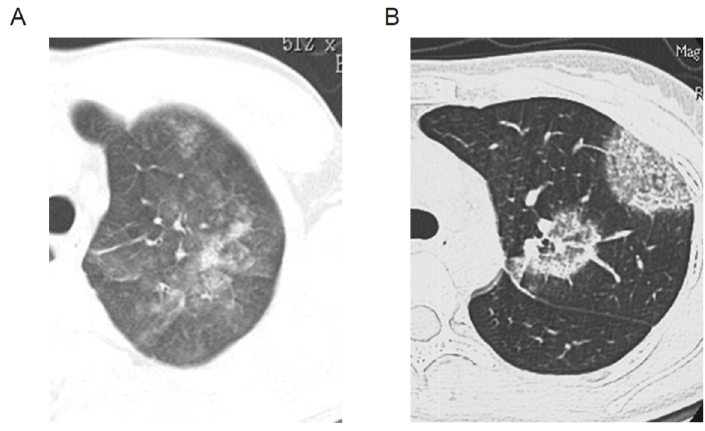
Figure 1. Findings of computed tomography (CT) in acute eosinophilic pneumonia (AEP) and chronic eosinophilic pneumonia (CEP). ( A ) shows the findings of CT in AEP. Ground-glass opacity/airspace consolidation and interlobular septal thickening are representative CT findings of AEP. ( B ) shows the findings of CT in CEP. Bilateral or unilateral airspace consolidation predominantly in the peripheral region (photographic negative pattern) is a representative CT finding of CEP.